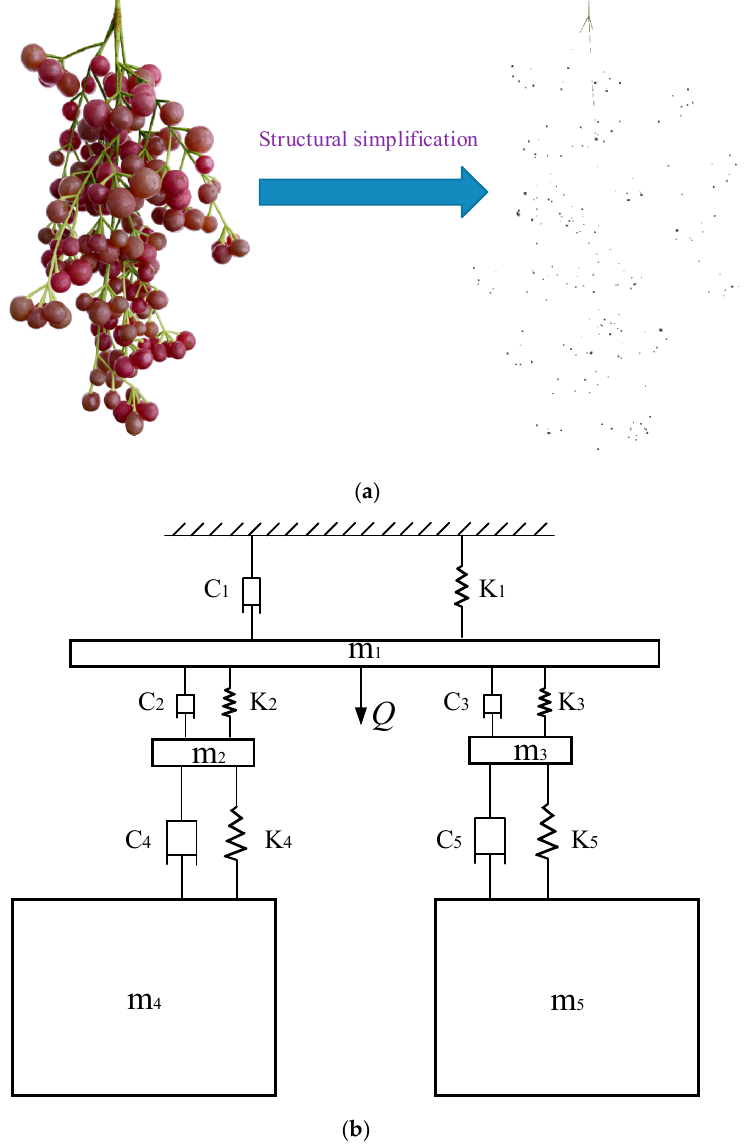
Figure 2. Development and dynamic model of the grape fruit–stem system oscillation. ( a ) The team studied the structure of the fruit. ( b ) Dynamic model of the grape fruit–stem system oscillation.